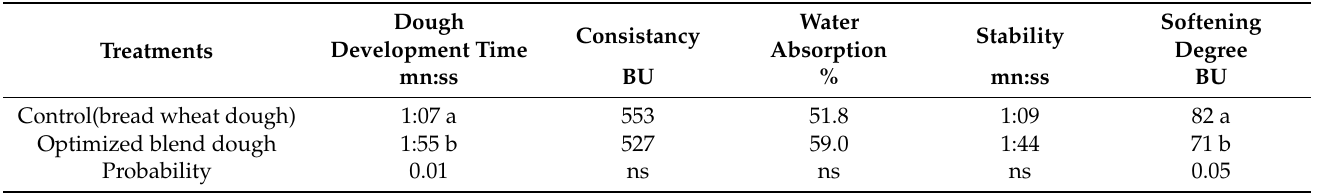
Table 3. Farinograph parameters of the optimal composite flour